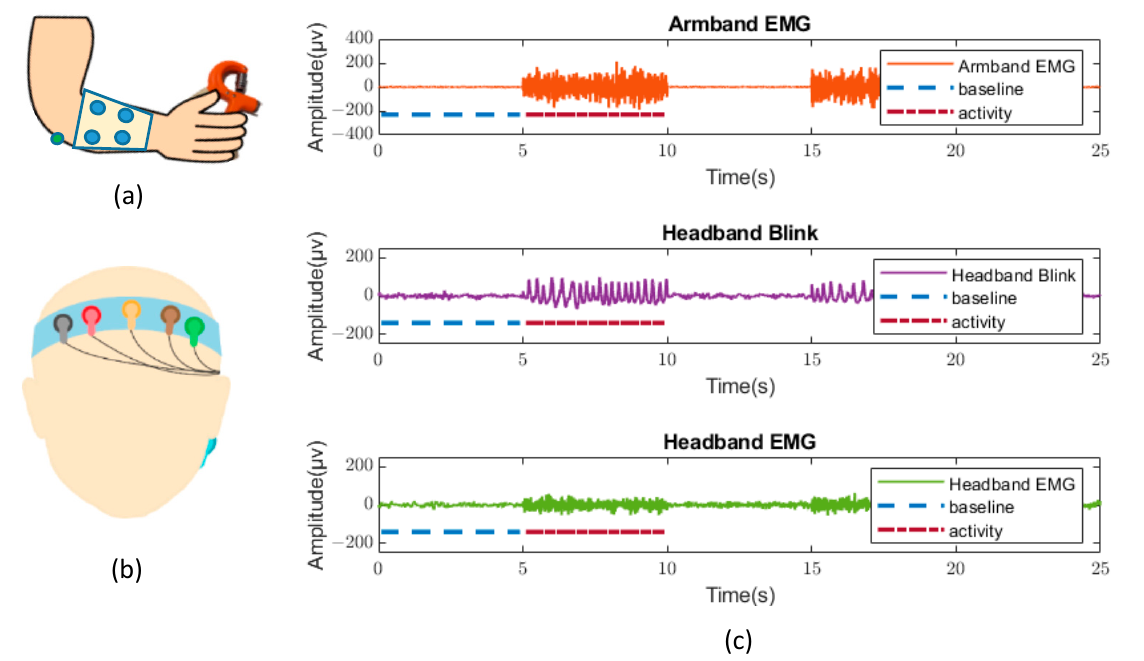
Figure 3. Schematic diagram of example recordings with the forearm sleeve and headband. ( a ) Forearm sleeve was used to record muscle activity vs. rest. ( b ) Headband was used to record blinks (eyelid closure) and frontal muscle activity (wrinkling of the forehead). ( c ) Sample recordings of the armband sleeve and the headband.